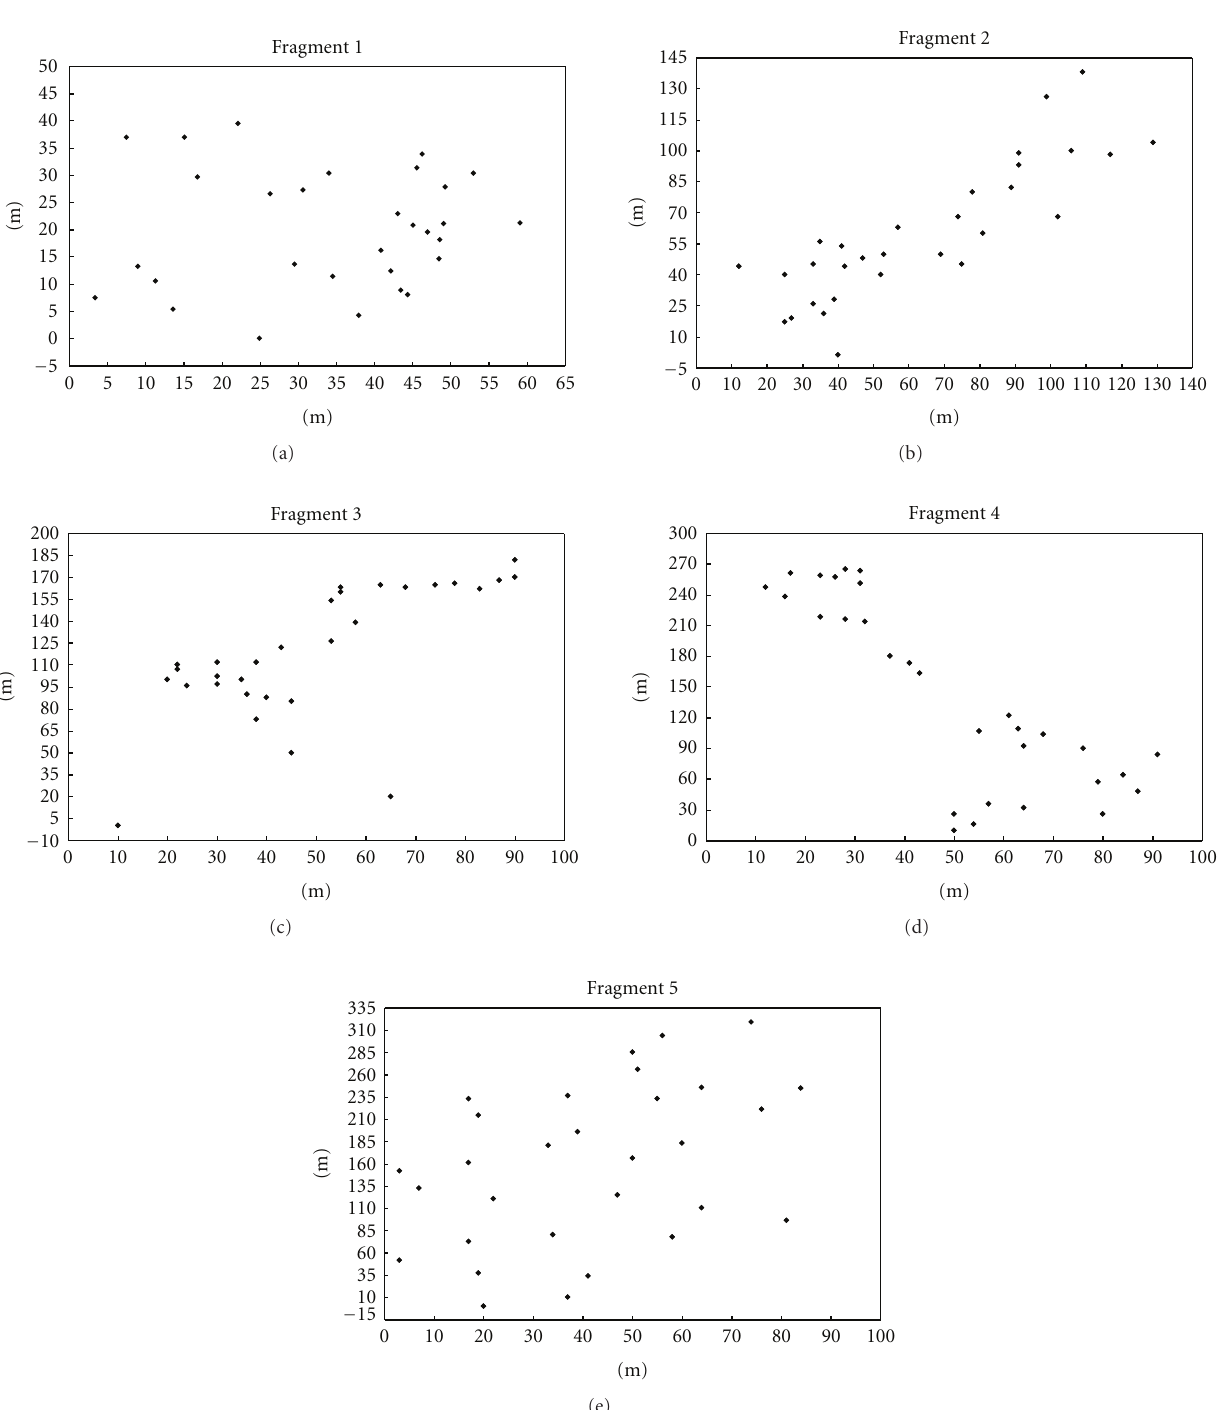
tree, connectivity by ecological corridors, low genetic dif- ferentiation among fragments was actually expected and observed ( F ST = 0 . 027). Results obtained for genetic di ff erentiation between fragments and ecological corridors corroborate this hypothesis, because all fragments have generally lower genetic di ff erentiation with corridors which